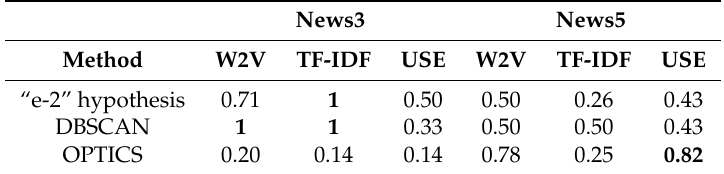
Table 7. The number of clusters’ inference accuracy for News3 and News5.